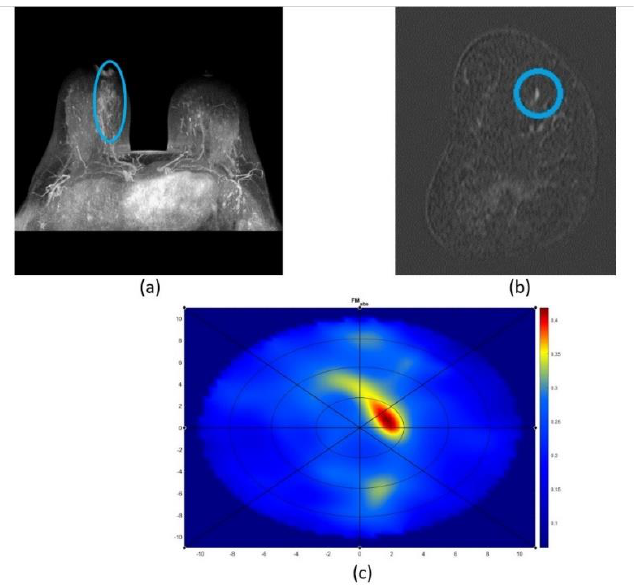
achieved were 80%, 100% and 88%, respectively.